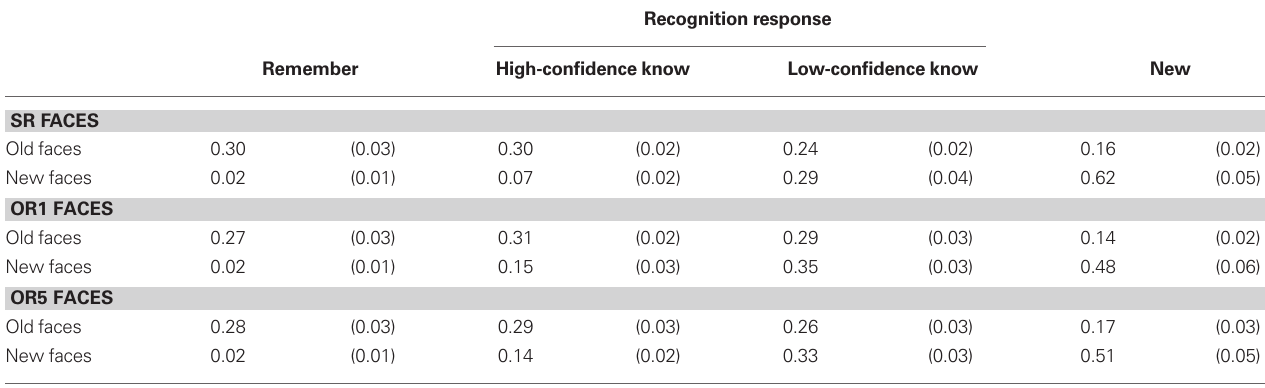
Table 1 | Recognition memory performance for each experimental